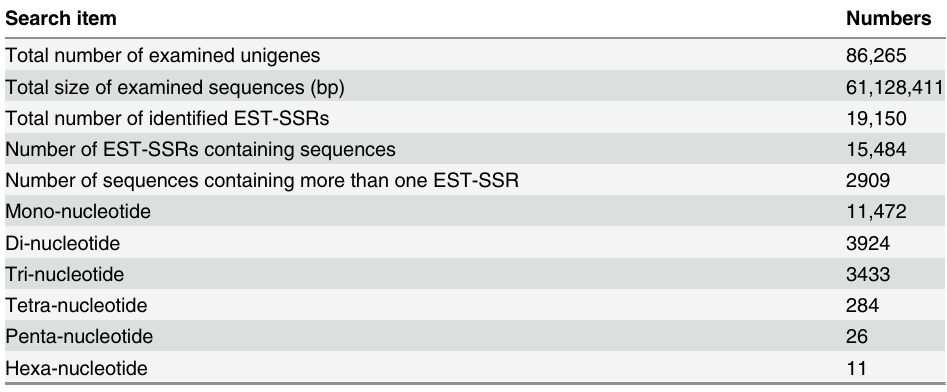
Table 3. Summary of the EST-SSRs that were identi fi ed in the